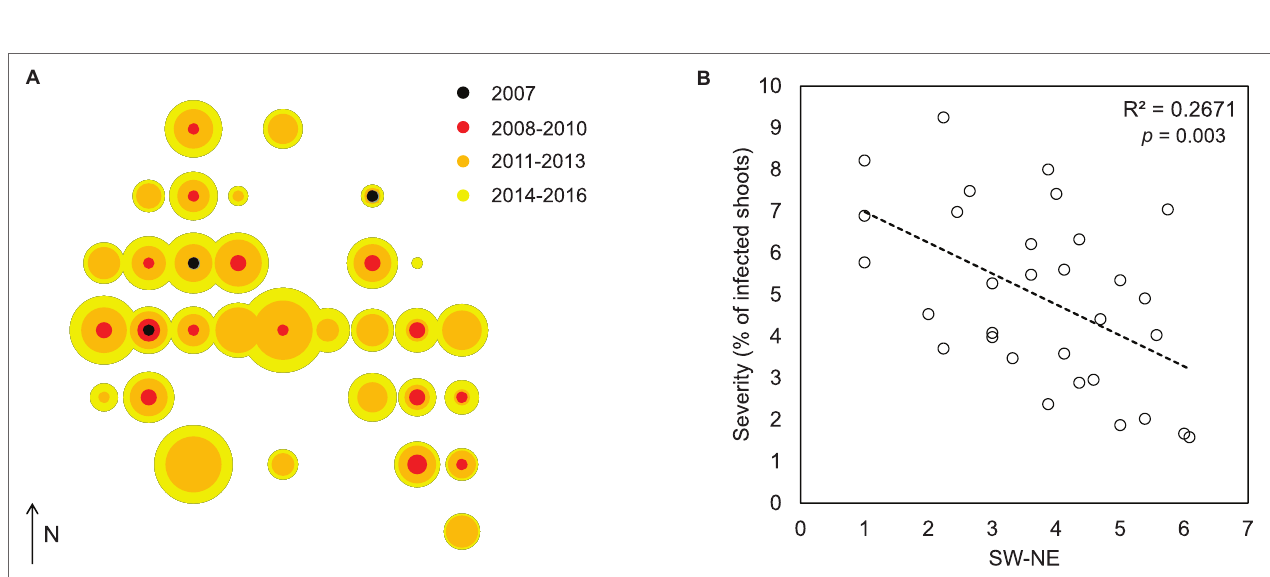
FIGURE 3 | Spatial and temporal spread of D. sapinea within the affected Scots pine stand (A) and association between severity in 2016 and location ( n = 31 stands) (B) . SW-NE was calculated as the product of the relative X and Y coordinates of the sampling plots; higher values indicate NE locations, while low values indicate SW locations. Both severity and SW-NE location are plotted following square-root